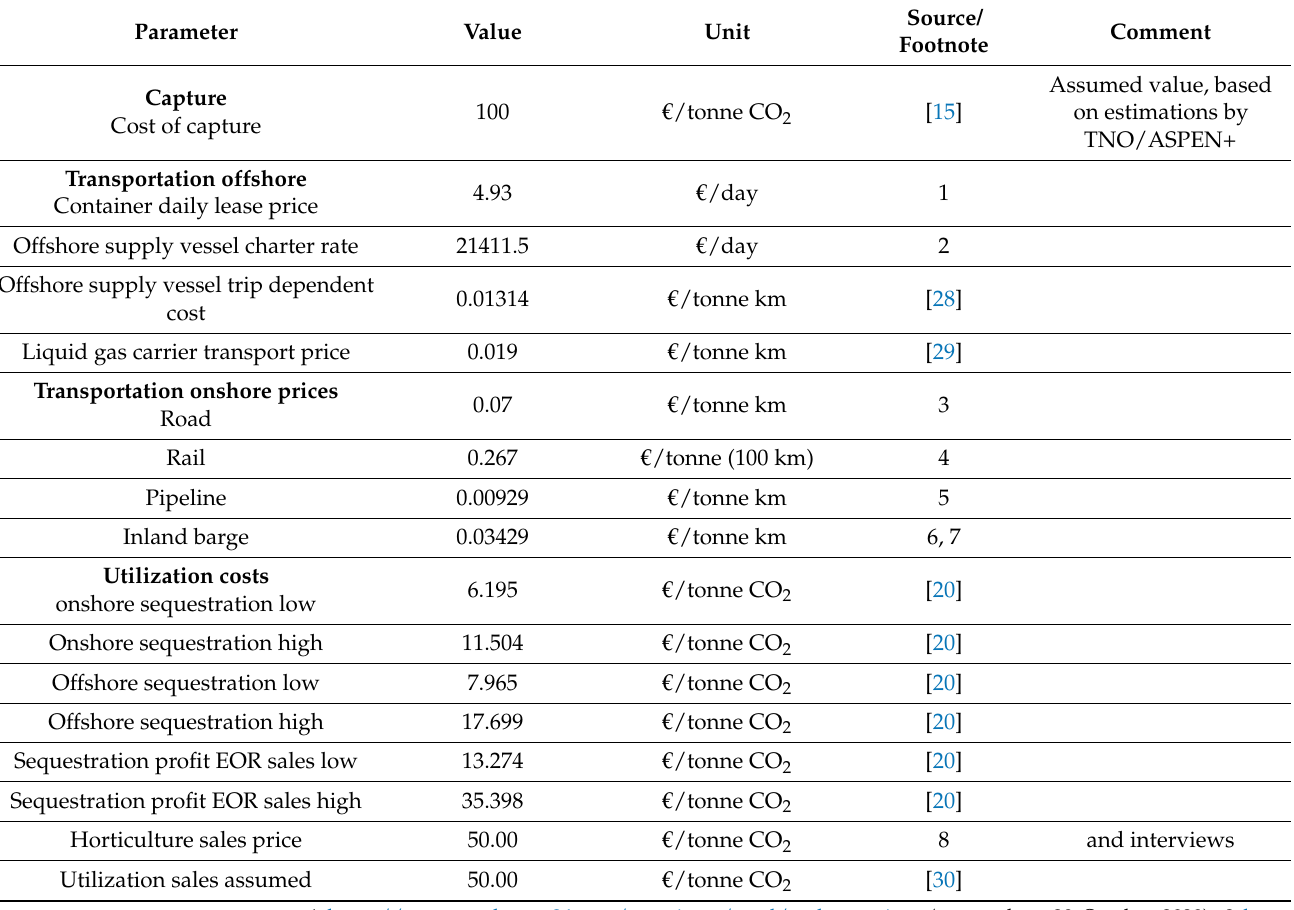
Table A1. Economical assumptions and calculated constants. Sources without brackets are listed in footnote of